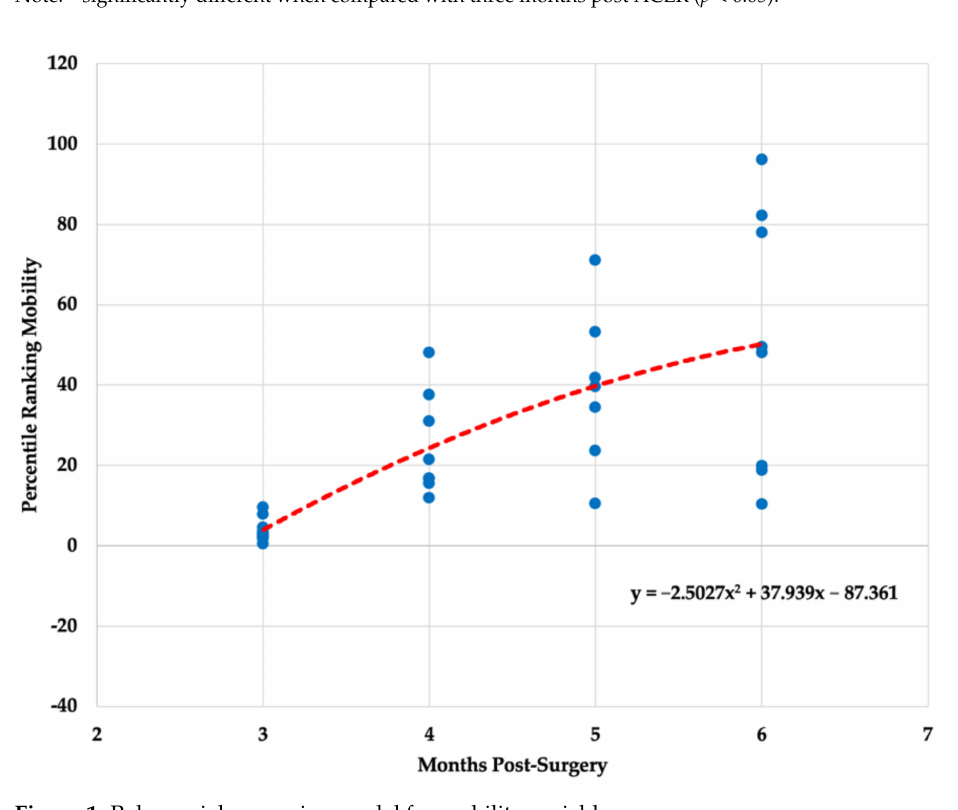
Figure 1. Polynomial regression model for mobility